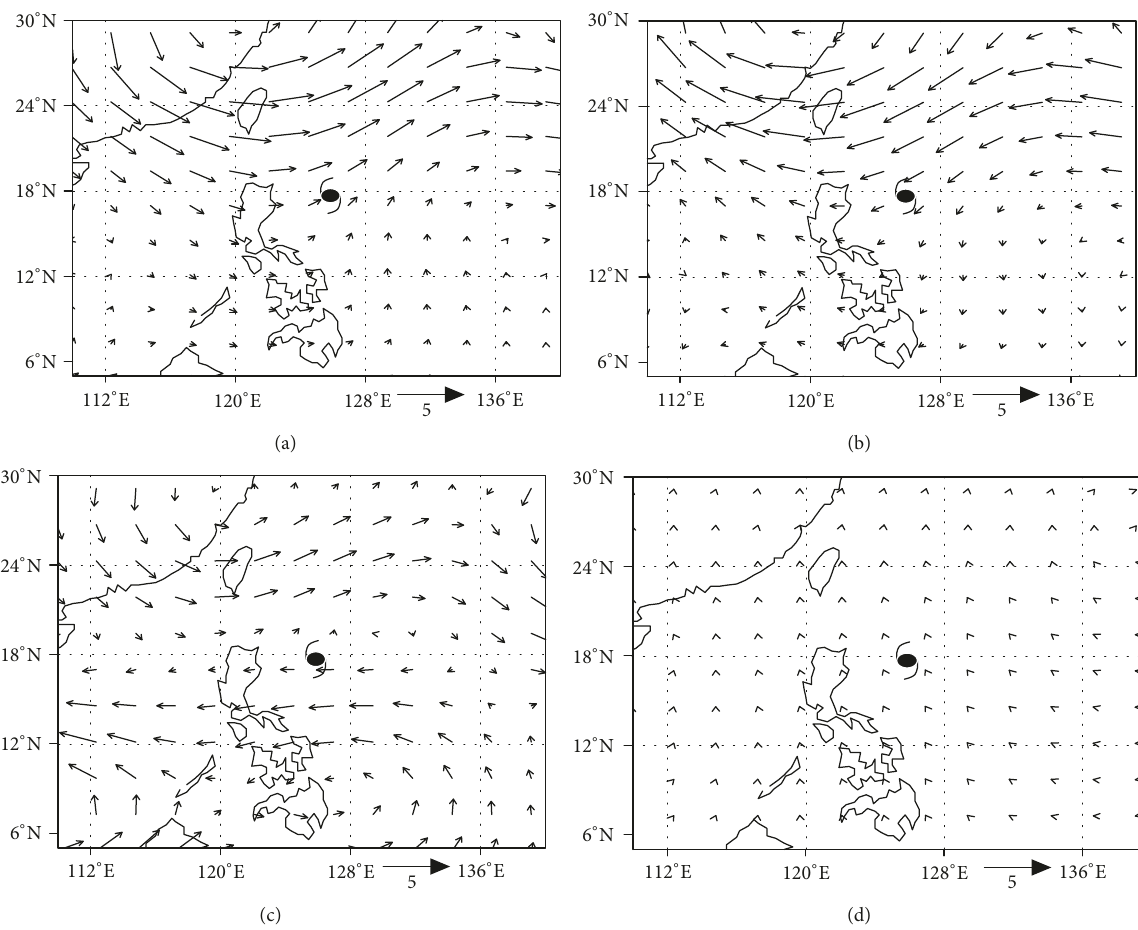
Figure 7: The initial 500 hPa wind field deviation (unit: m/s) (a) AIRS-CTRL; (b) AIRS_GRD-AIRS; (c) AIRS_SYB-AIRS; (d)